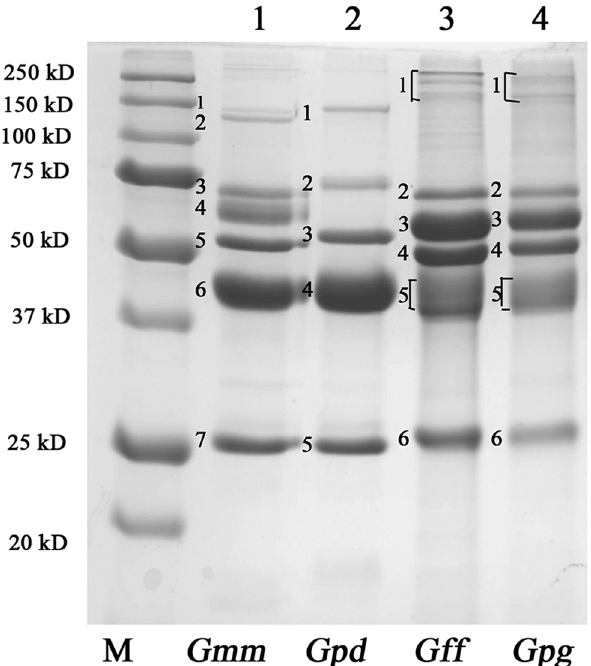
Fig 1. SDS PAGE analysis of saliva from different tsetse species. Lanes 1 – 4 show protein profiles of Gmm , Gpd , Gff and Gpg sialomes analyzed by SDS-PAGE analysis stained by Coomassie Blue. M indicates the Molecular Weight marker. Bands referred to in the sialome of each species are numbered from top to bottom. One representative image for the sialome data is shown. Additional results from SG extracts and replicate sialome samples are shown in S1